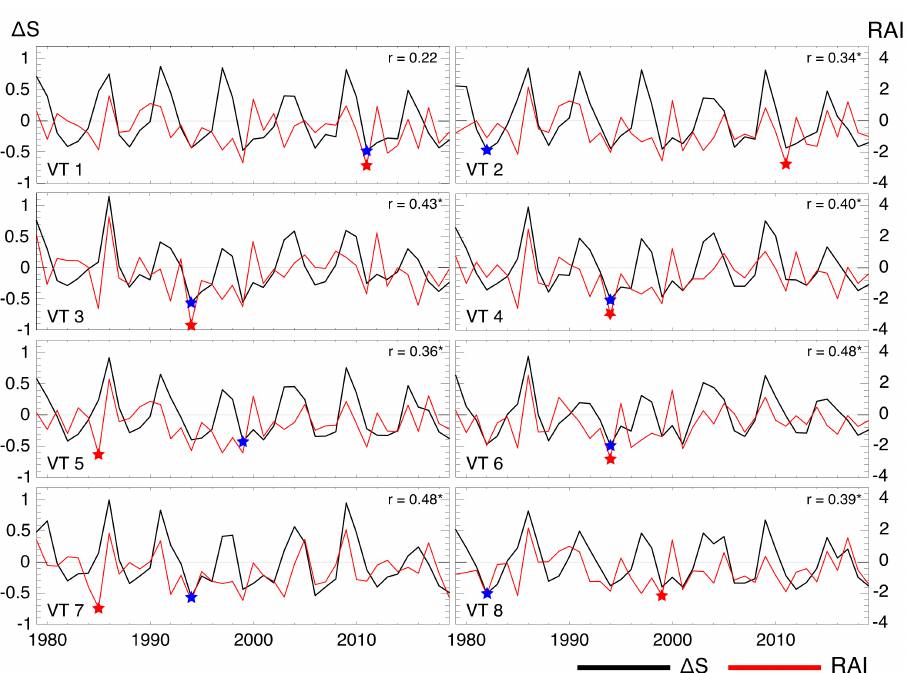
Figure 5. Annual drought for each vegetation type calculated using ERA5 data in the Korean Peninsula. Black line, ∆ S ; red line, Rain Anomaly Index (RAI); blue star, minimum value in ∆ S ; red star, minimum RAI values; *, statistically significant at the 0.05 level.